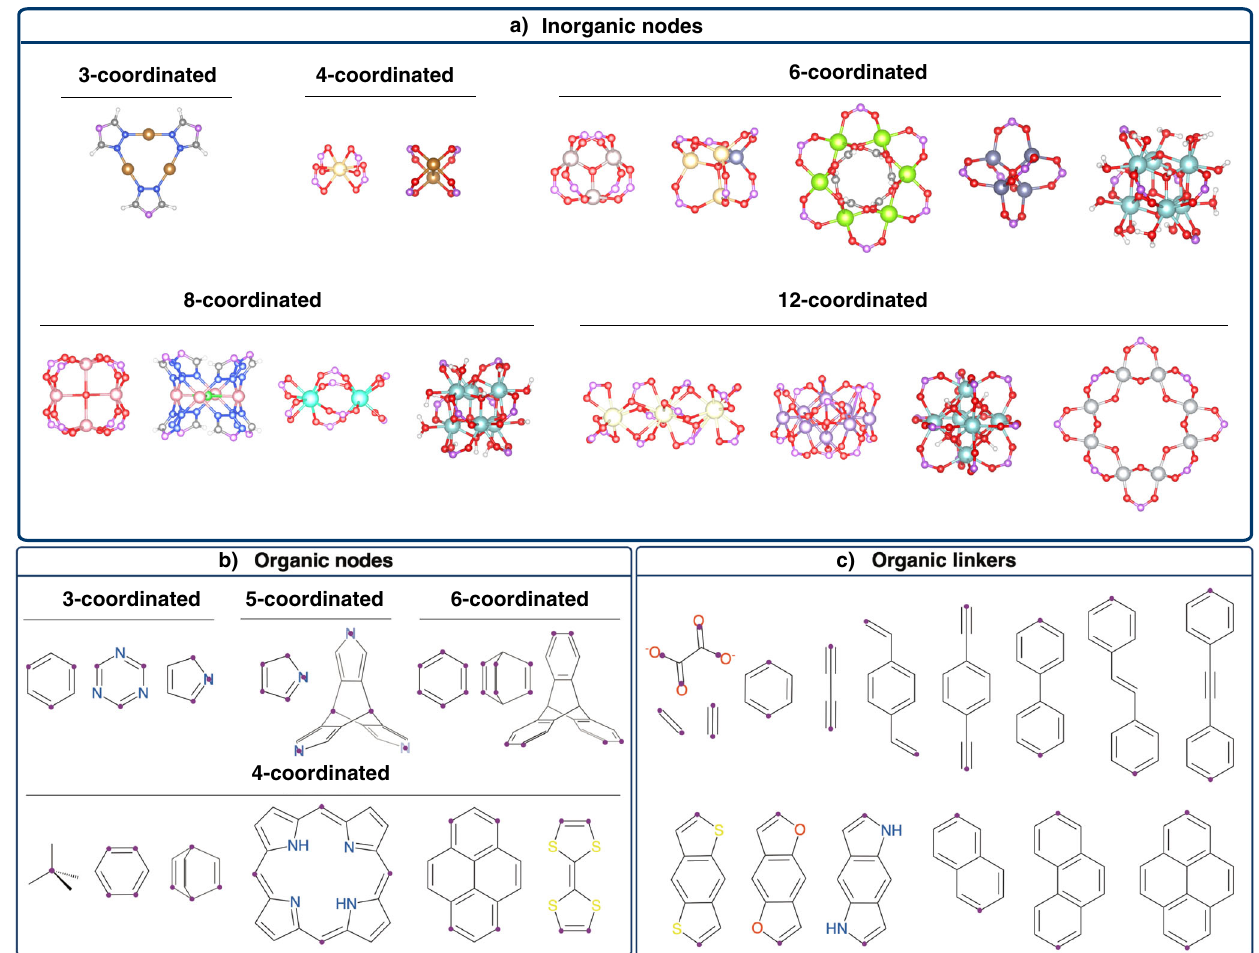
Fig. 1 Building blocks that are used to build 10,194 hypothetical MOFs containing 1015 topologies. a inorganic nodes; b organic nodes; c organic linkers. The connecting points to other building blocks are represented with violet circles. For remaining inorganic nodes and organic linkers with functional groups, see Supplementary Figs. 1 and